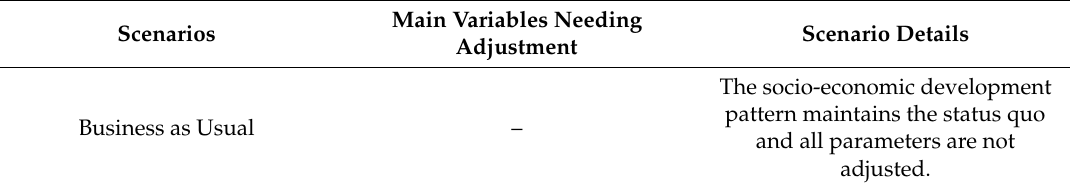
Table 5. The details of the di ff erent economic development